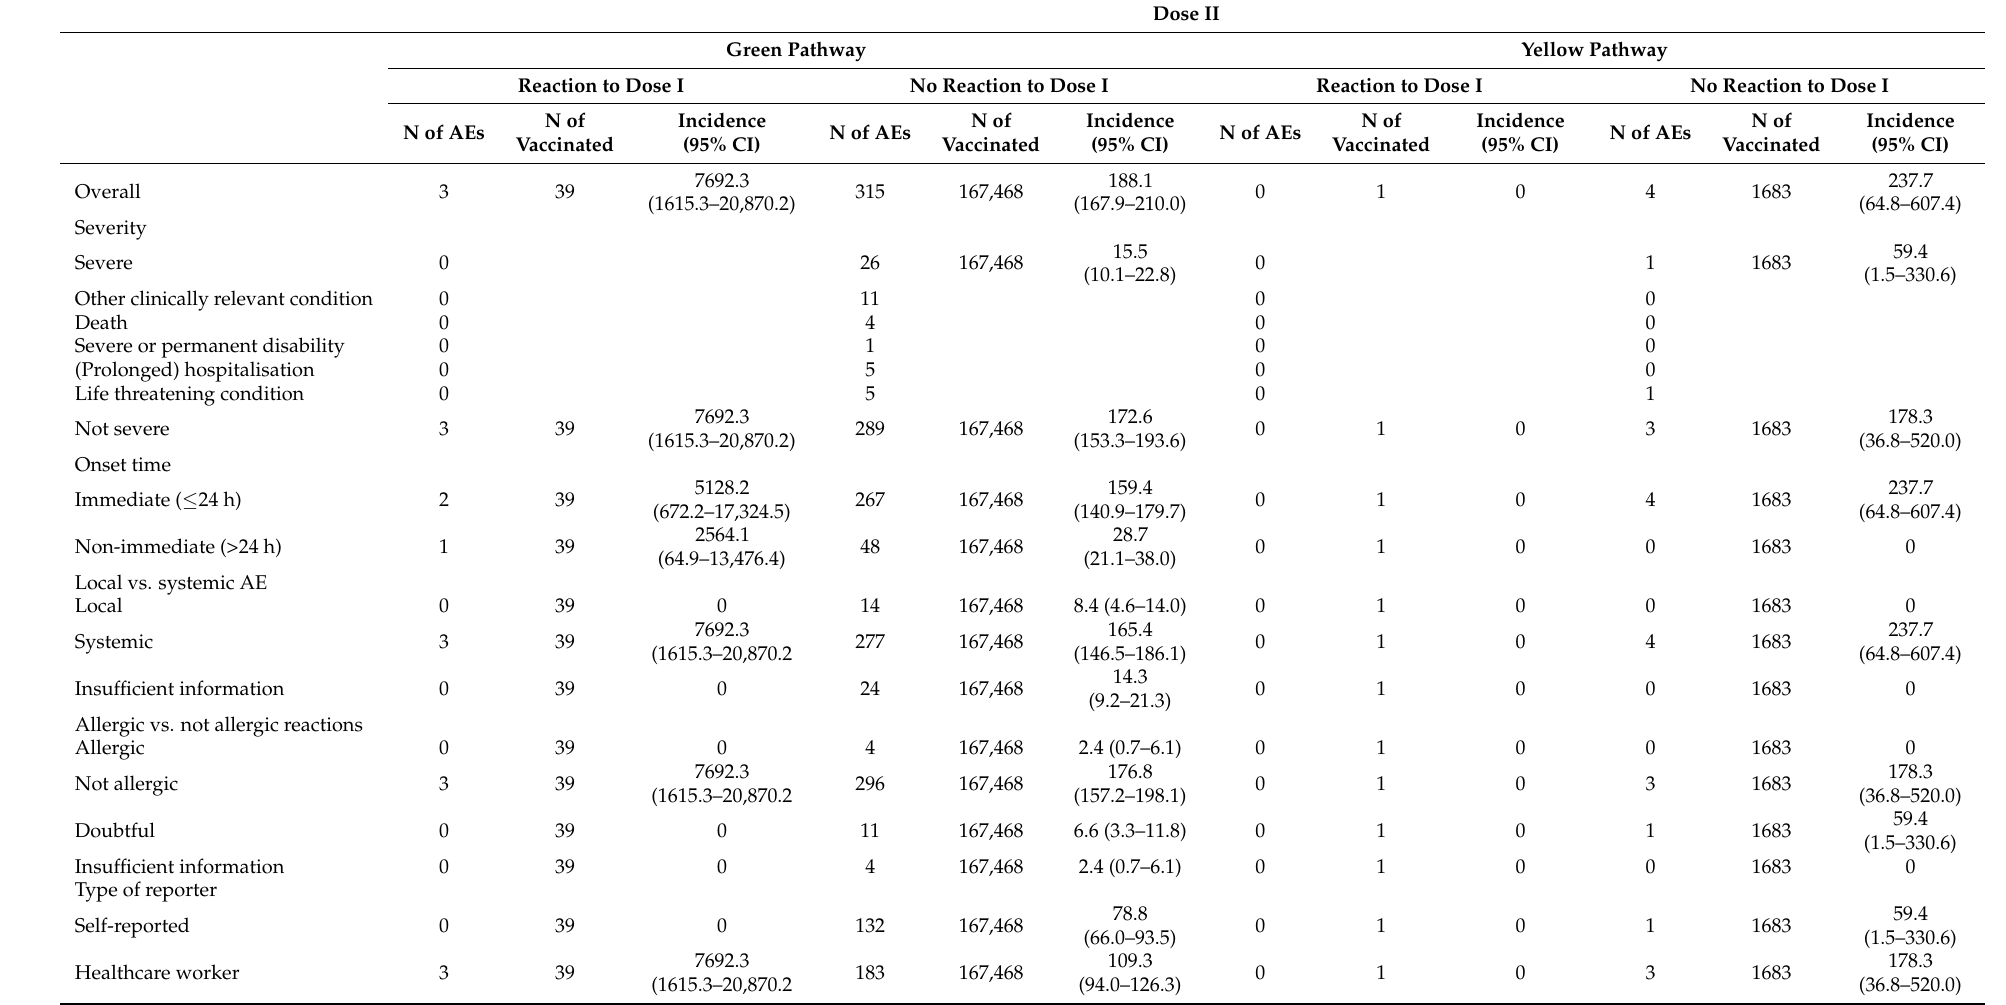
Table 3. Characteristics of adverse events after the second dose of COVID-19 vaccine, by risk